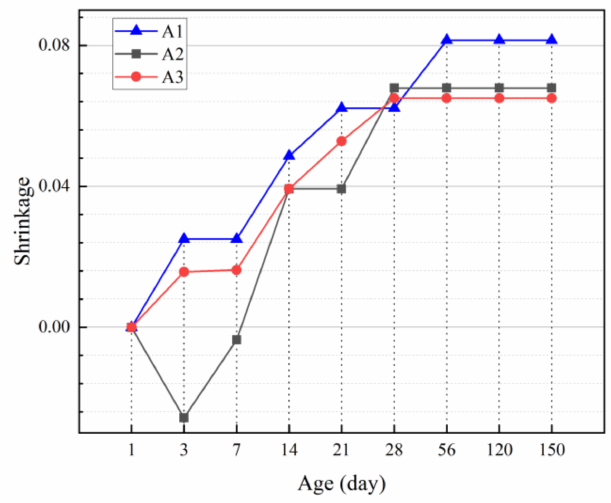
Figure 16. Shrinkage of UHPC based on composite cementitious